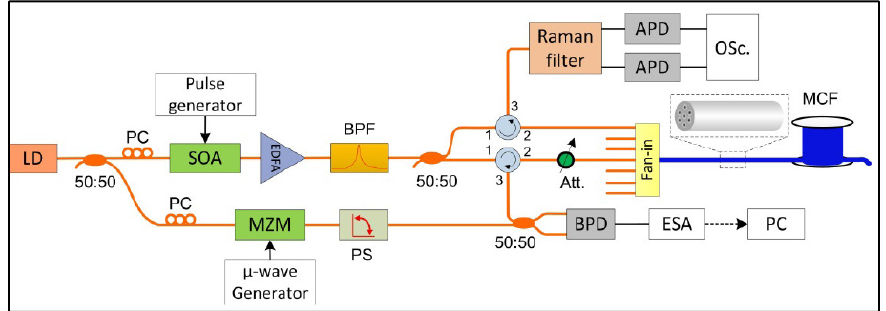
Figure 8. Experimental setup of the MCF based SDM hybrid ROTDR and BOTDR system. (Reprinted/Adapted) with permission from [51] © The Optical Society.